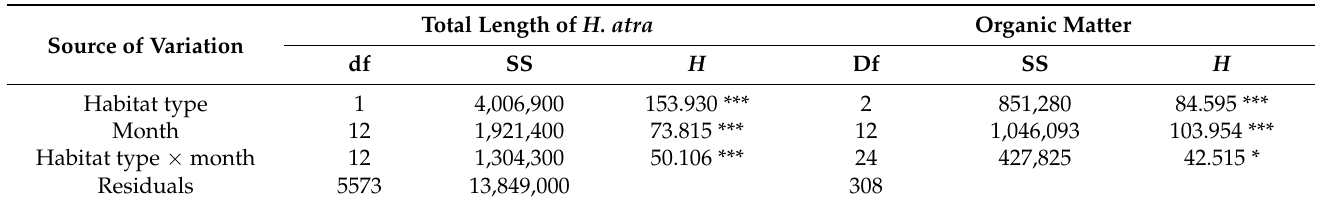
Table 1. Results of Scheirer-Ray-Hare testing of data of the effects of habitat type and month on total length of H. atra and sedimentary organic matter.